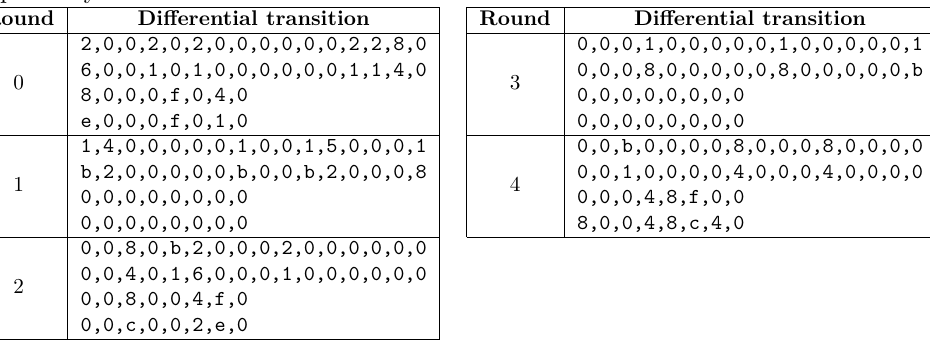
Table 4: A 5-round differential characteristic of SKINNY-64-128 that is not a plateau characteristic. The first, second, third, and fourth row in each cell of the table represent the difference before SB, the difference after SB and the round key (TK1 and TK2) involved respectively in hexadecimal notation.